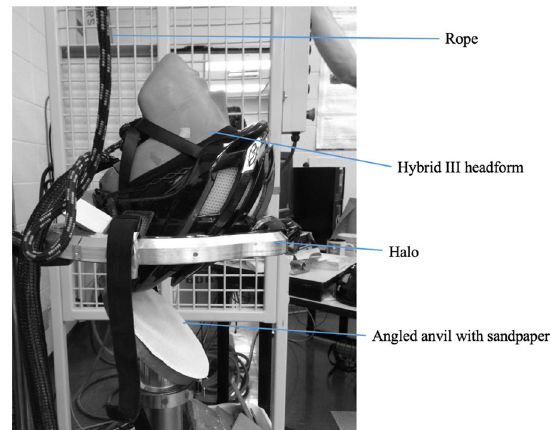
Figure 2. Drop rig, halo and 45° anvil with the sandpaper affixed.